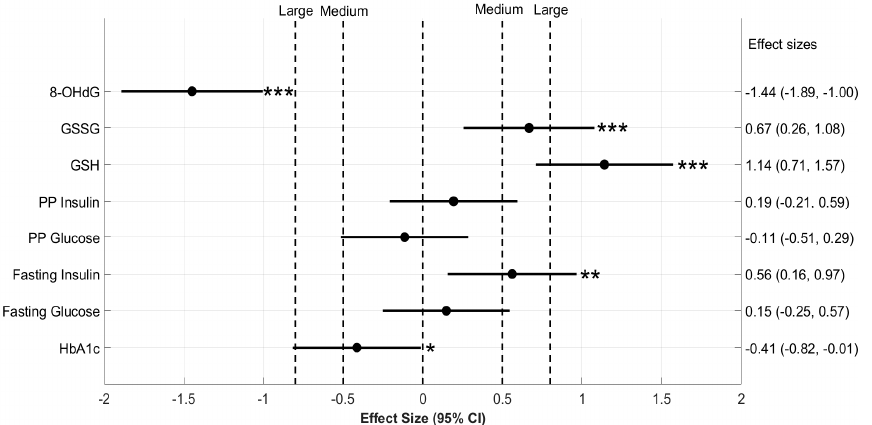
Figure 5. The effect size of changes in blood biochemical parameters of elderly diabetic patients. Six-month changes in the biochemical parameters of those in D and DG sub-groups were compared here on a forest plot with effect size and 95% confidence intervals. Effect size (Cohen’s d) calculated between 6-month changes in the concentration of biochemical variables are denoted on the x -axis. The group-wise means of 6-month changes in the concentration of these variables were compared using two ‐ sample permutation tests. The significance of these comparisons is denoted by the p val ‐ ues mentioned to the right of horizontal lines for CI. Significance levels are * p < 0.05, ** p < 0.01, and *** p < 0.001 for respective comparisons.